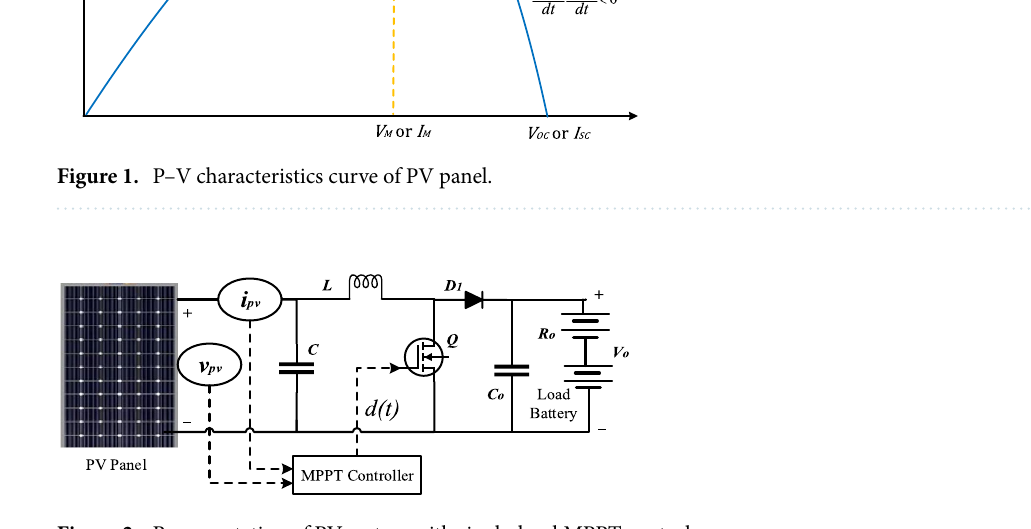
Figure 2. Representation of PV system with single-level MPPT control.